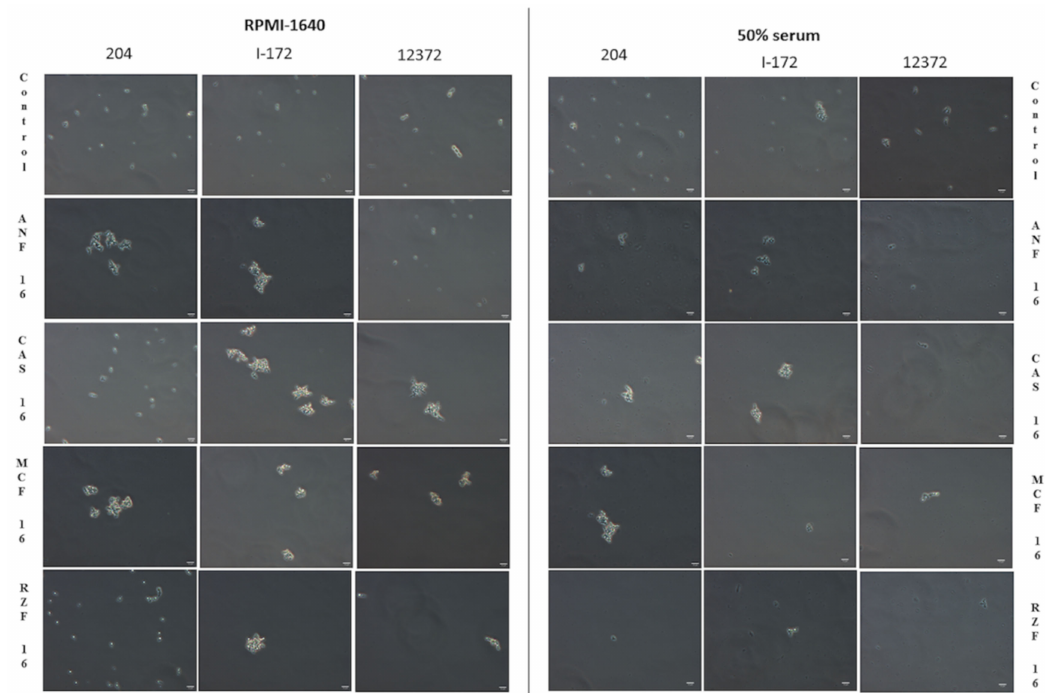
Figure 3. Phase-contrast microscopy images of untreated C. auris cells and cells treated with 16 mg/L rezafungin (RZF), 16 mg/L anidulafungin (ANF), 16 mg/L caspofungin (CSF), and 16 mg/L micafungin (MCF) in RPMI-1640 and RPMI-1640 plus 50% human serum (50% serum) against isolates 204 (South African clade), I-172 (South American clade) and 12,372 (East Asian clade). The micrograph was taken after 24 h. In RPMI-1640, single and budding cells or short chains with small aggregates containing up to 3–6 cells were observed in controls. In 50% serum, the appearance of the untreated isolates was similar, but small aggregates (up to 5–10 µ m in diameter) were more frequently observed. In RPMI-1640, all four echinocandins induced large aggregates in the case of isolate I-172, and ANF and MCF in the case of isolate 204, while CSF and MCF in the case of isolate 12372. In 50% serum, large aggregates could be observed only in cases of isolate 204 with CSF and MCF, and isolate I-172 with CSF. Abnormal cell morphology and cell debris were typical after 24 h. Bar: 10 µ